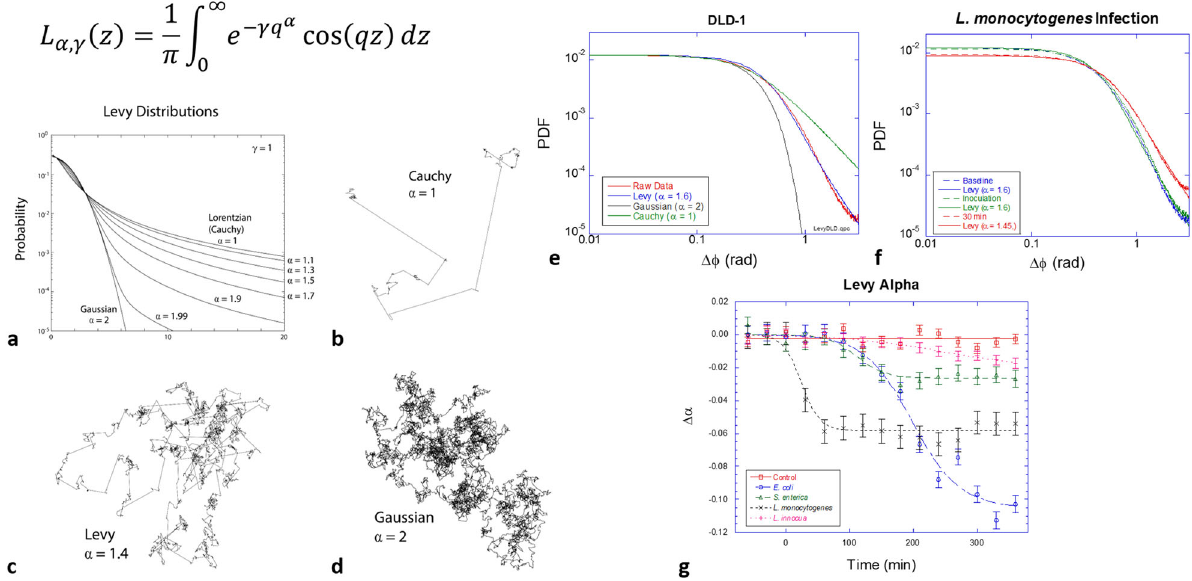
Fig. 5 Lévy statistics in living tissue and anomalous random walks associated with Levy fl ights. a Lévy probabilities. Lévy processes with smaller alpha have more frequent ballistic motions and are less ballistic with larger alpha. b – d Examples of Lévy random walks displaying the heavy tail of persistence lengths. e The PDF of DLD-1 tissue with a Lévy exponent of α = 1.6. f The PDF of tissue infected by L. monocytogenes (10 7 CFU/well), showing a measurable shift to α = 1.4 in only 1.5 h. g Temporal shifts of Levy exponents from multiple samples infected with the four strains of bacteria. Error bars represent standard error. A logistic function was used to fi t the